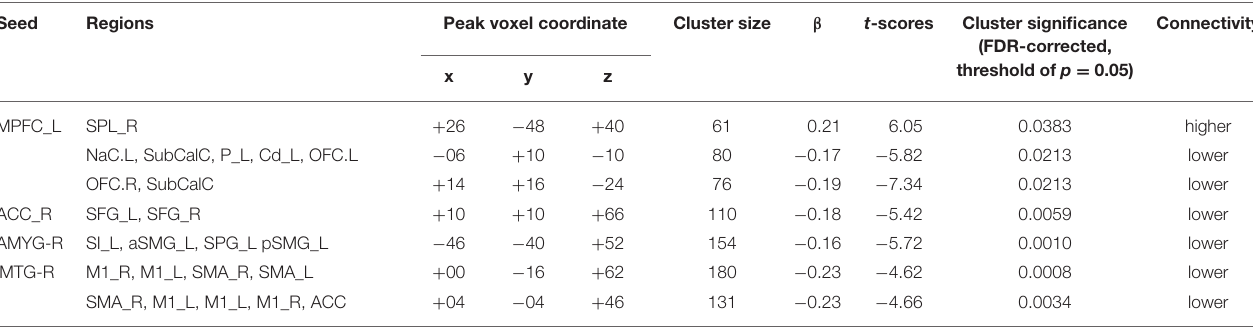
TABLE 3 | Seeds showing significant functional connectivity differences between groups (BPD > HC) with age as covariate. Seed Regions Peak voxel coordinate Cluster size